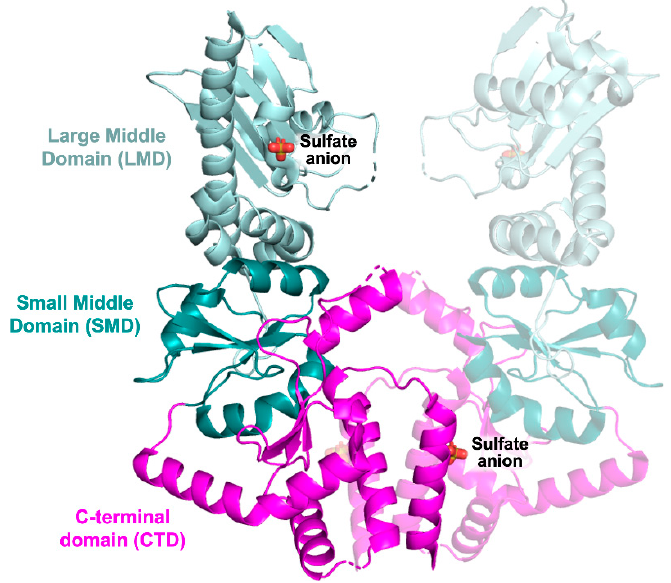
Figure 5. Crystal structure of the Lm -MD–CTD dimer (PDB id 3HJC, unpublished results). The partner subunit, generating the protein dimer, is represented in transparency. The LMD is colored light cyan, the SMD cyan, and the CTD magenta. Sulfate anions are displayed in sticks.